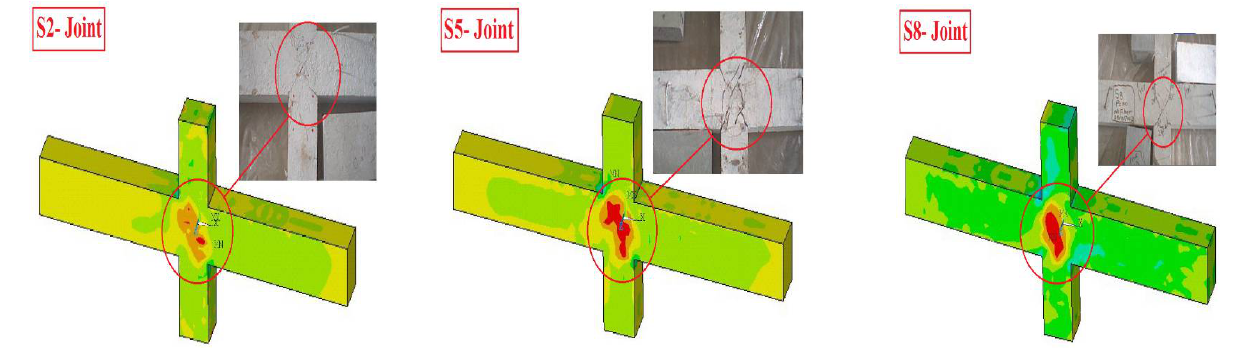
Figure 5. Failure modes validation.